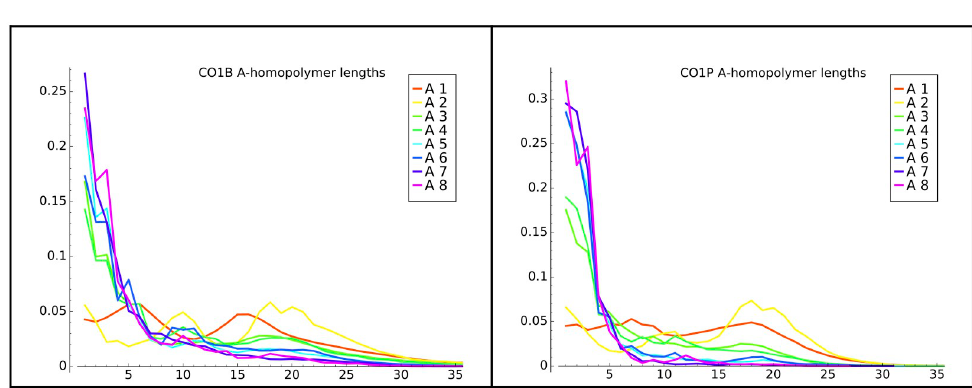
Fig 3. CO1B and CO1P A-homopolymer distributions. The frequency distribution of lengths of A-homopolymers in CO1B and CO1P transcript tail populations. A1 indicates the first homopolymer encountered starting from the first nucleotide of non-templated addition, A2 indicates the second, on to the eighth encountered homopolymer (A8), in the populations of tails in which they occur.